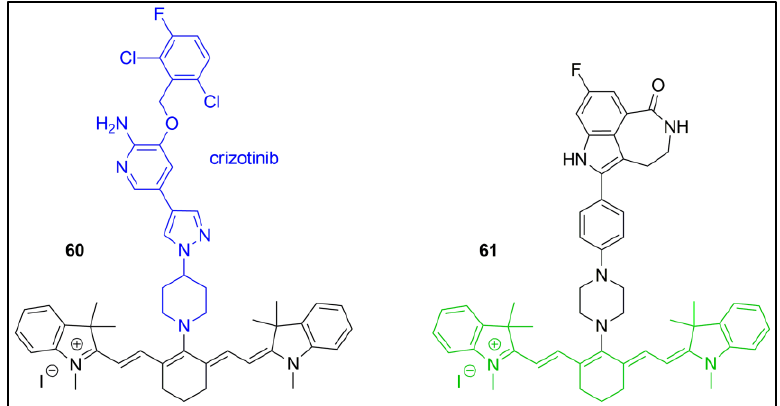
Figure 56. Structure of compounds 60 and 61 [164,165].